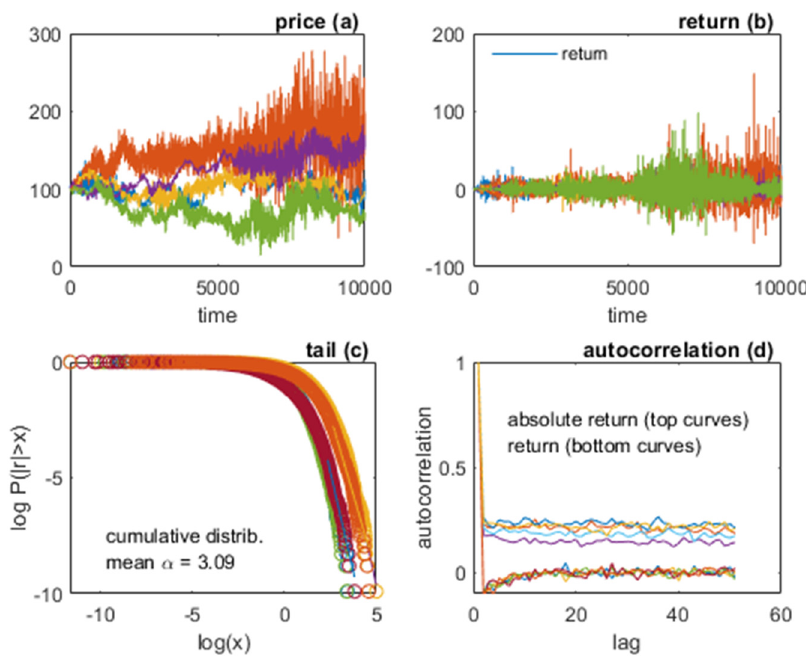
Figure 4. The purely news-driven market model: five simulations superposed: ( a ) price; ( b ) return; ( c ) tail; ( d ) autocorrelation function of return and absolute return.